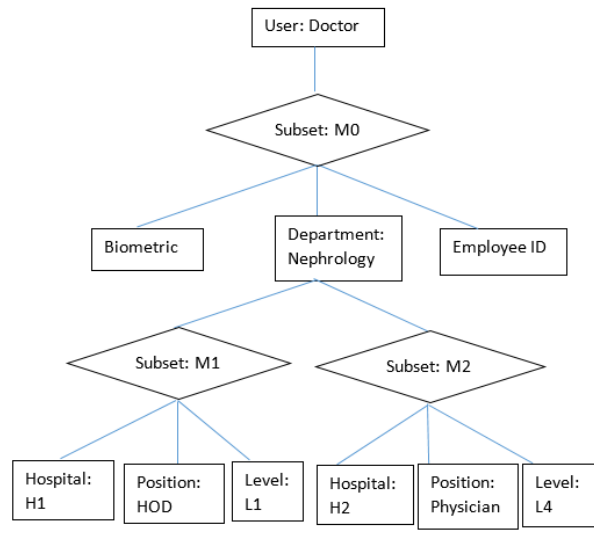
Figure 2. Example Key Structure